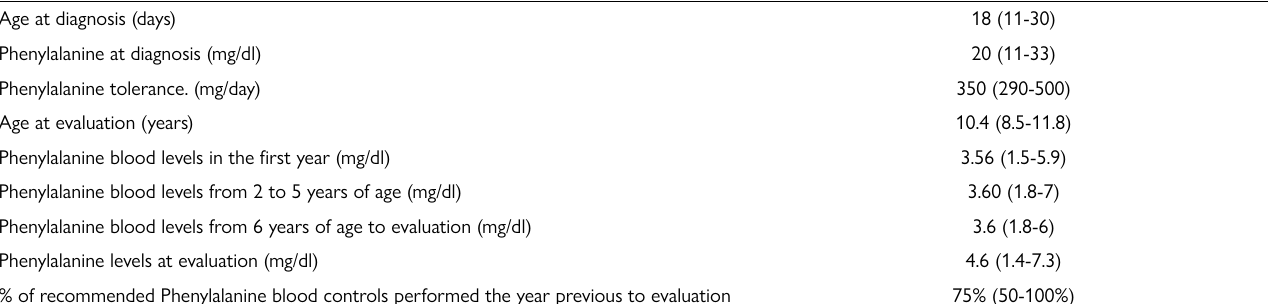
Table 1. Initial and follow up characteristics of the 30 studied PKU children. (Median (range)). Age at diagnosis